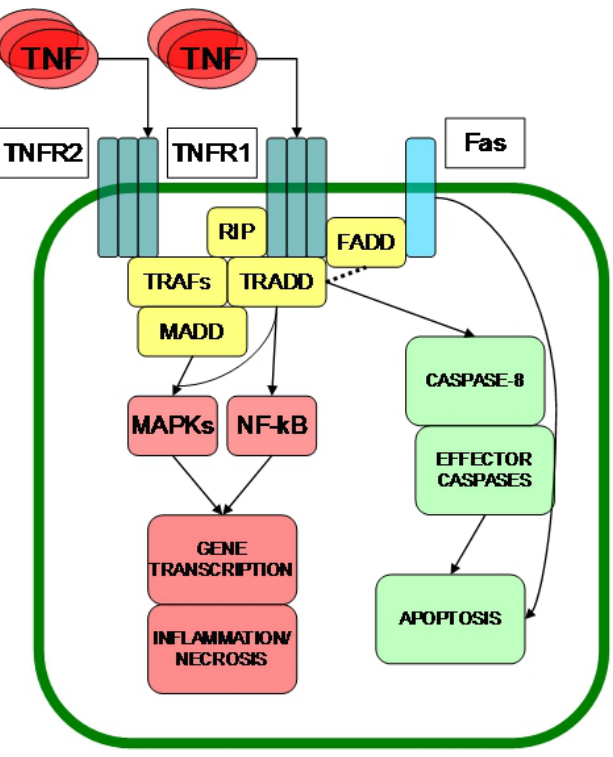
FIGURE 3 . TNF- α mediates both apoptosis and necrosis. TNF- α can trigger both apoptosis and inflammation/necrosis through recruitment of different adaptor proteins. TRADD is the proximal transducer of apoptosis and requires an interaction with FADD to activate